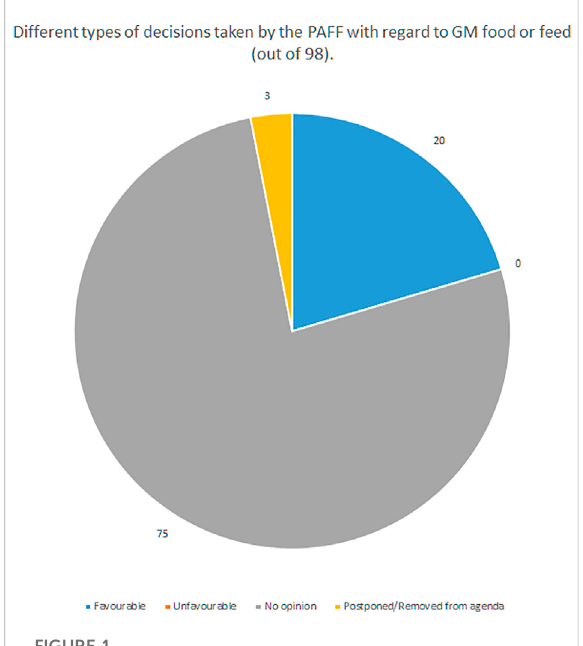
FIGURE 1 Different types of decisions taken by the PAFF with regard to GM food or feed between 10.2014 and 1.2022 (Zimny,